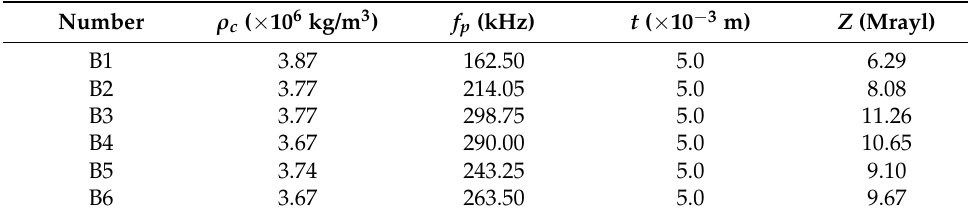
Table 9. Changes in Z of specimens with modulus.